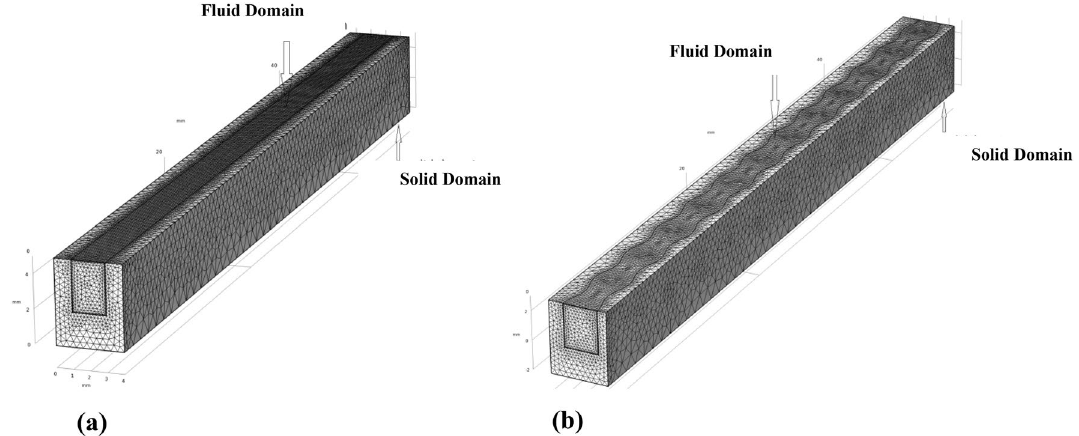
Figure 2. Mesh distribution of a computational domain ( a ) conventional channel ( b ) wavy